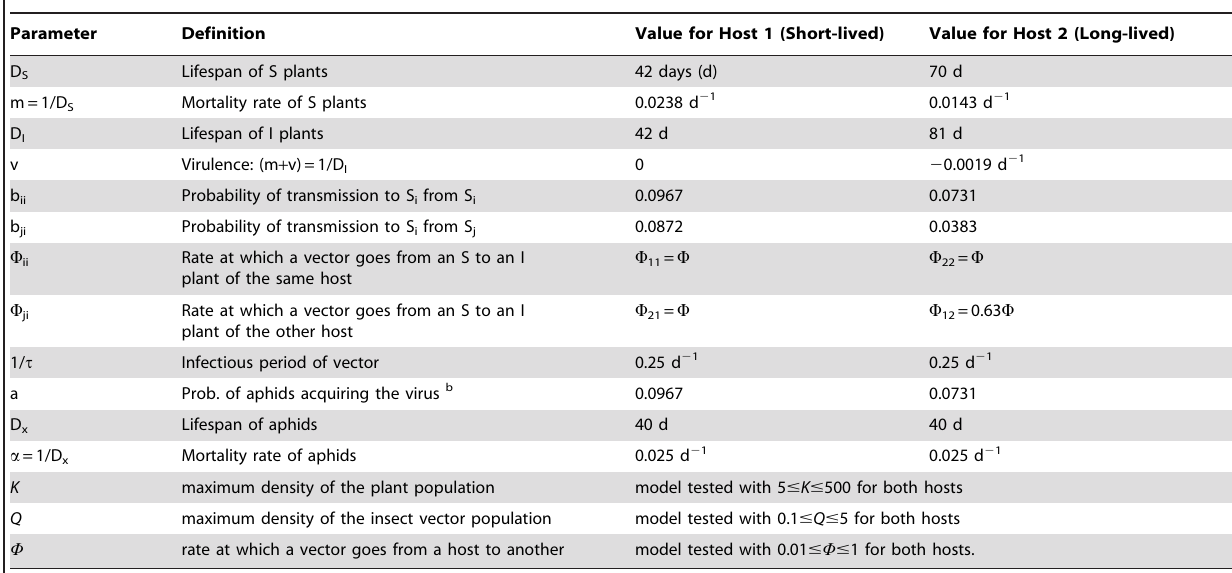
Table 5. Parameter values for model